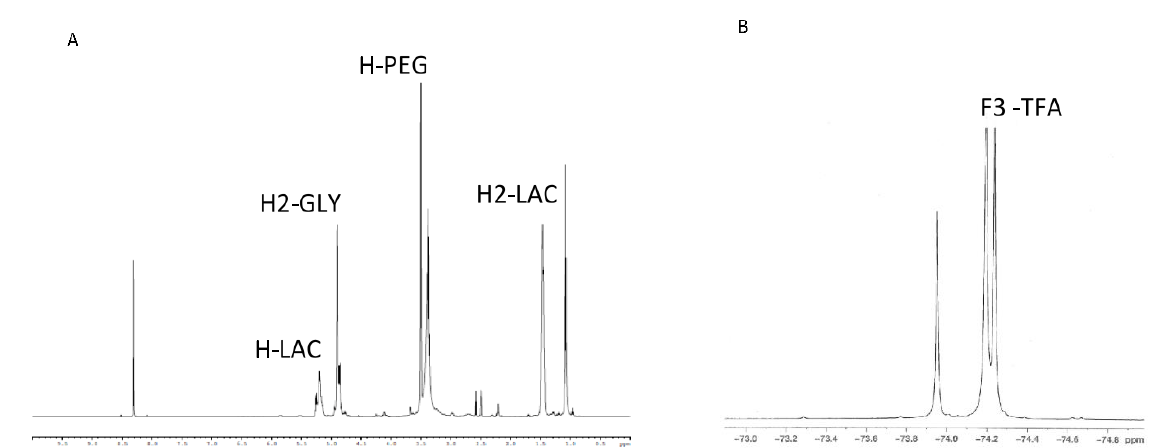
Figure 2. NMR characterization of functional copolymers. ( A ) 1 H-NMR spectrum of PLGA-PEG-TFA in DMSO. ( B ) 19 F-NMR spectrum of PLGA-PEG-TFA in D 2 O.